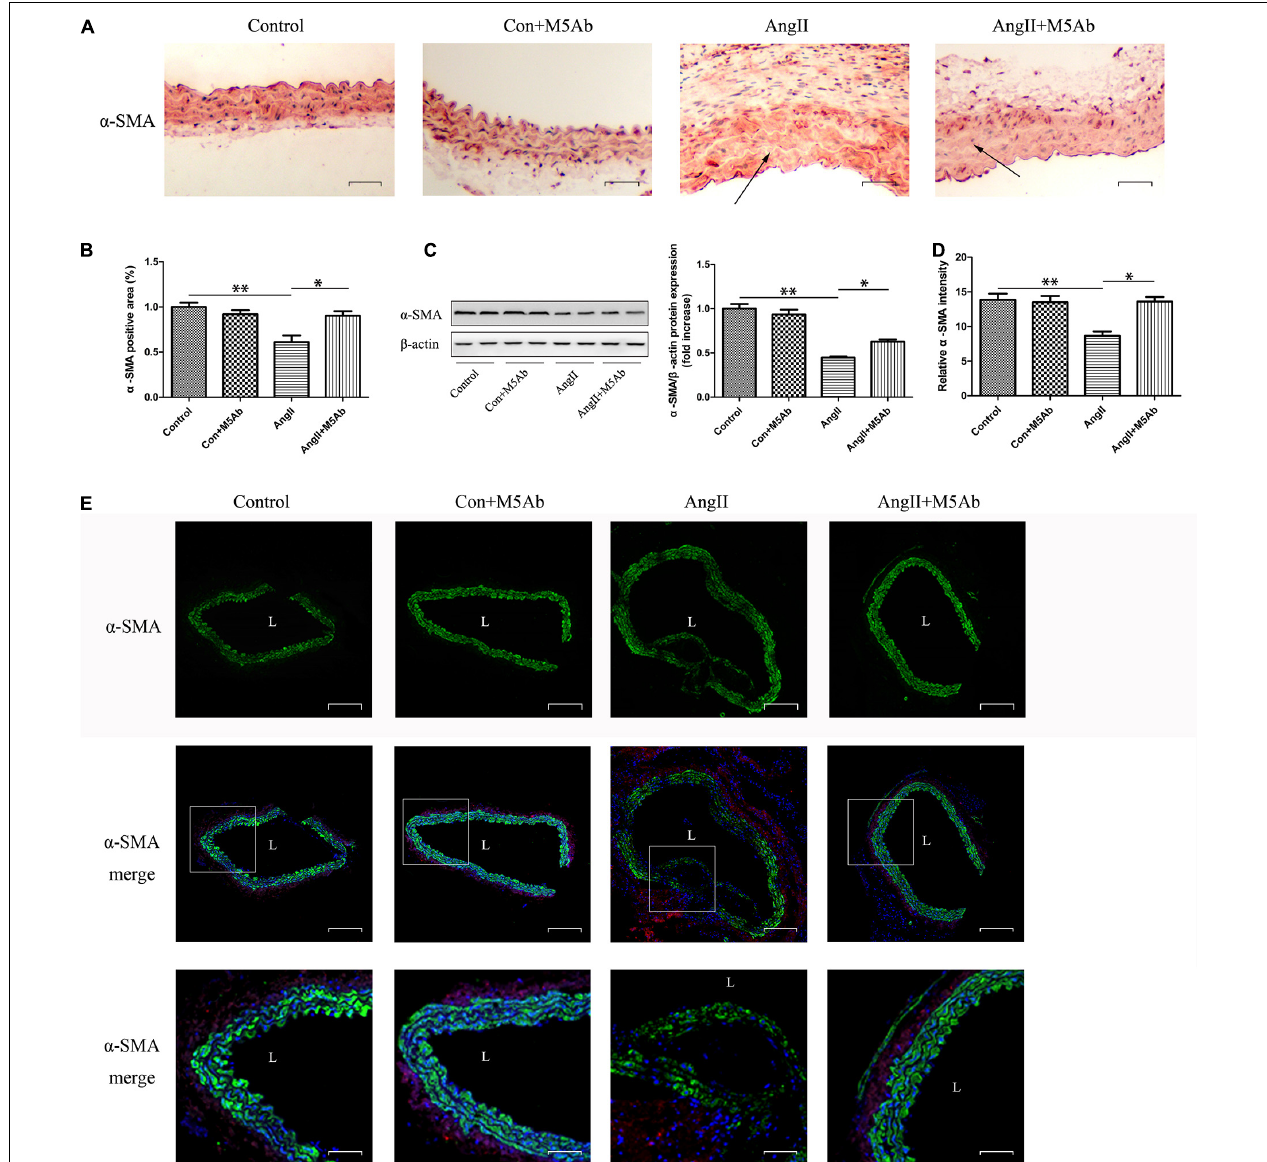
FIGURE 7 | M5Ab decreases the downregulation of α -SMA in the AAA group mice. (A,B) Immunohistochemistry staining of α -SMA in mice under different treatments (A) , quantification of α -SMA area (B) . Scar bar 25 µ m. (C) Western blotting analyses of the protein levels of α -SMA in mice, and quantification of α -SMA protein expression. (D,E) Representative α -SMA immunofluorescence staining of aortic tissues and quantification of α -SMA intensity (Scar bar 50 µ m), boxed areas in panel (E) are shown at higher magnification below (Scar bar 20 µ m). Data are expressed as means ± SEM; n = 3 per group. ∗ P < 0.05 vs the Ang II + M5Ab group; ∗∗ P < 0.05 vs the control and control + M5Ab groups. Abbreviations: Ang II, angiotensin II; SMA, smooth muscle actin; and L,